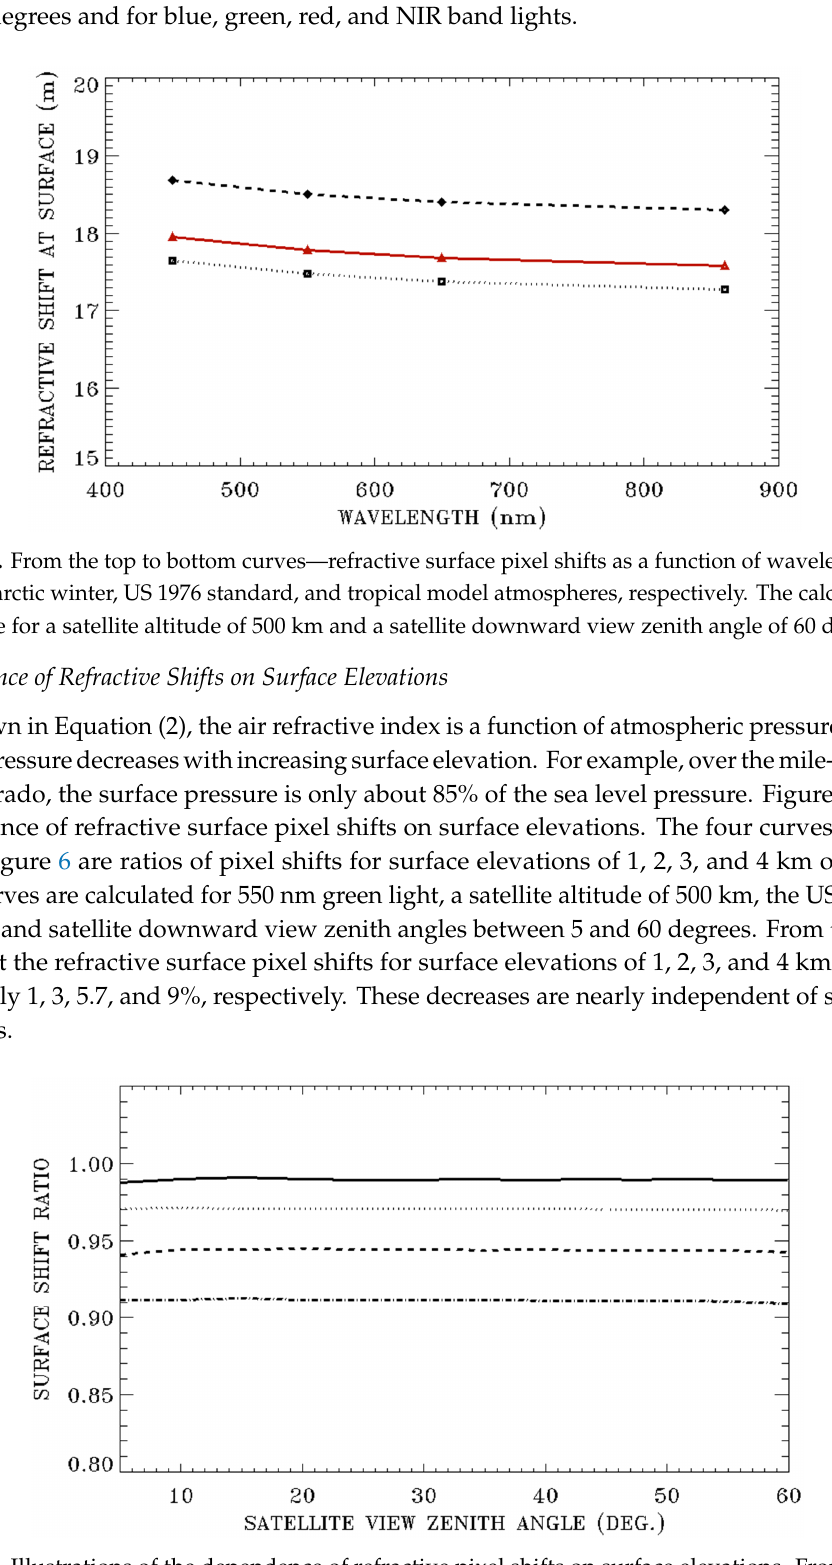
Figure 6. Illustrations of the dependence of refractive pixel shifts on surface elevations. From top to bottom, the curves are ratios of refractive pixel shifts for surface elevations of 1, 2, 3, and 4 km over those of 0 km, respectively.